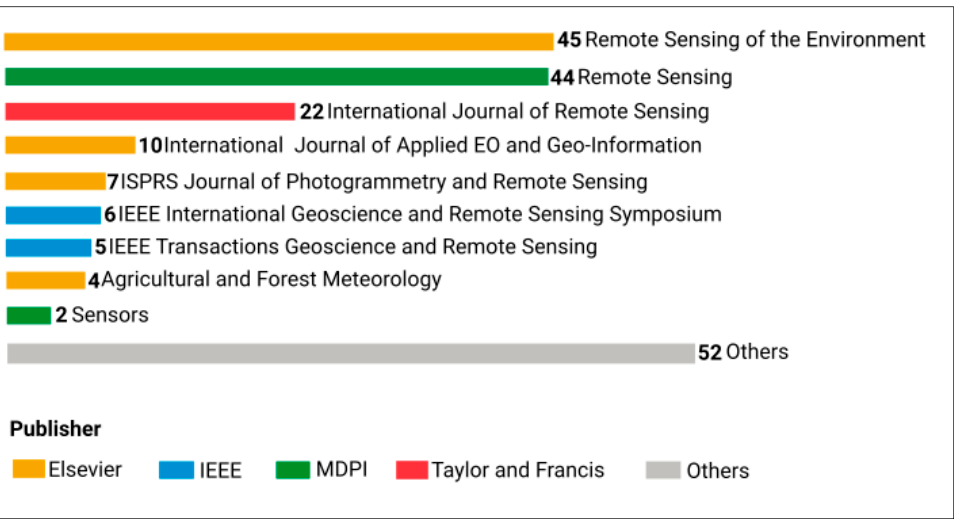
Figure 2. The overview of the final retained 197 papers, their publishers and the number of papers per journal.